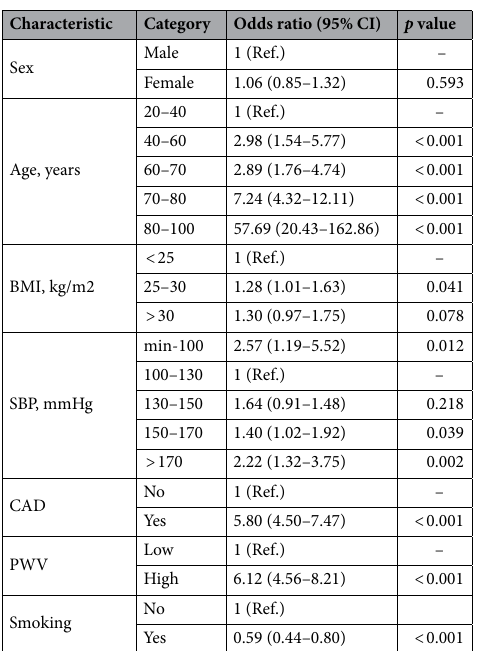
Table 3. Characteristics of participants and associations with low HGS (lower tertile). HGS handgrip strength, PWV pulse wave velocity, CAD coronary artery disease, BMI body mass index, SBP systolic blood pressure.